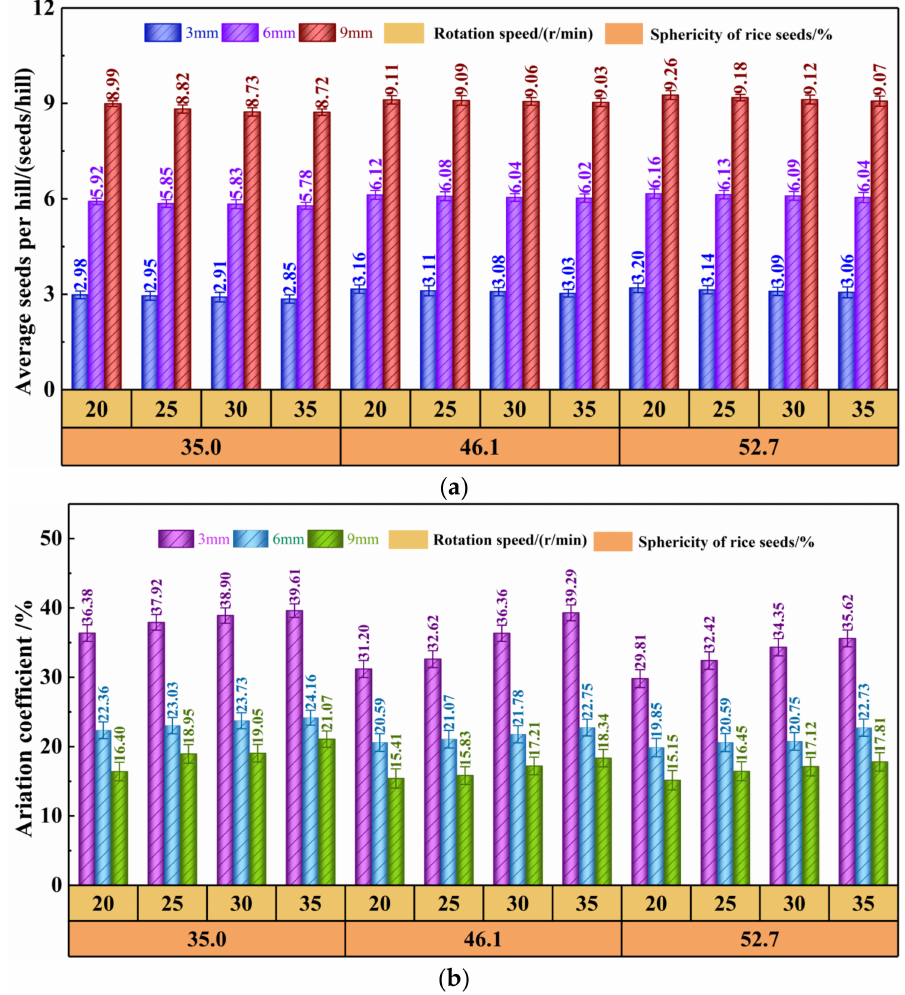
Figure 7. The average seeds per hill and the coefficient of variation under different rotational speeds and rice seed sphericity. ( a ) Effects of the rotation speed and rice seed sphericity on average seeds per hill; ( b ) the effects of the rotational speed and seed sphericity on the variation coefficient of the seed